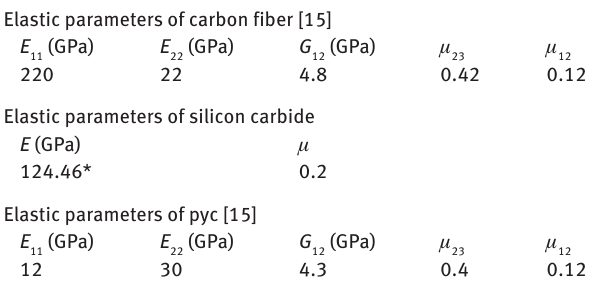
Table 1: Elastic parameters of components.